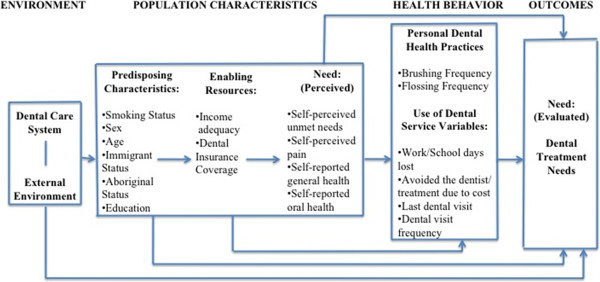
Operational model - Modification of Andersen’s Emerging Model (adapted from Andersen, 1995).